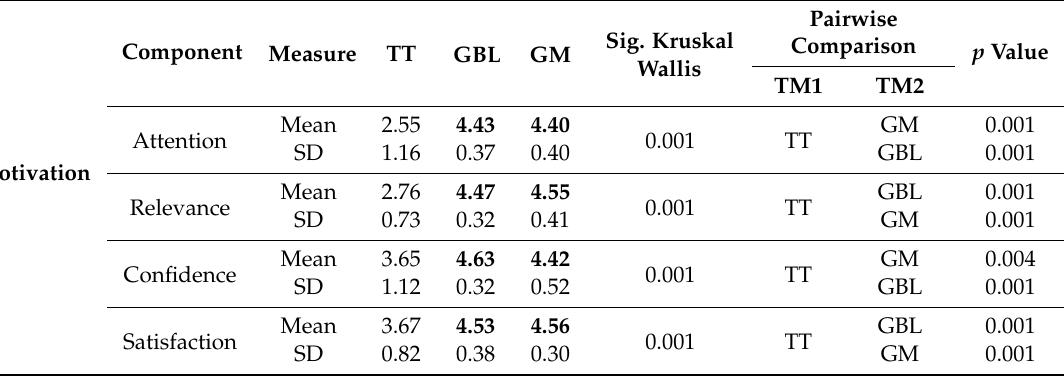
Table 3. Descriptive statistics (with means of the experimental groups in bold) and pairwise comparison of teaching methods for the Motivation